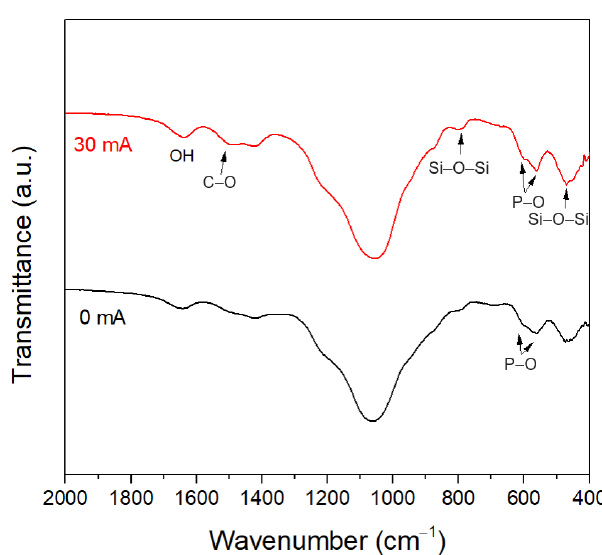
Figure 13. FTIR spectra of the glass samples immersed in SBF for 6 days.